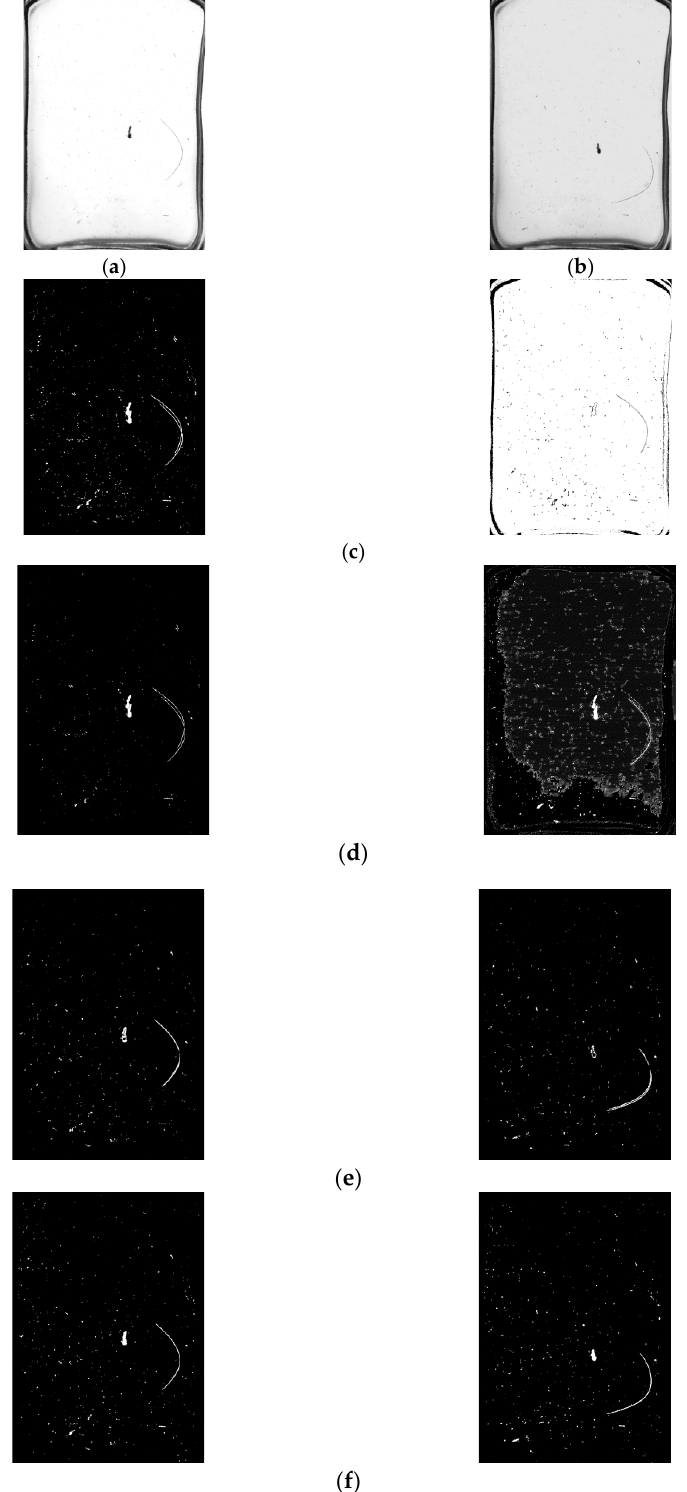
Figure 19. Examples of detection results for different algorithms when the light changes. ( a ) Frame 124; ( b ) Frame 144; ( c ) Result of traditional GMM background differencing method; ( d ) Result of the algorithm in literature [36]; ( e ) Result of frame difference method; ( f ) Result of method in this paper.